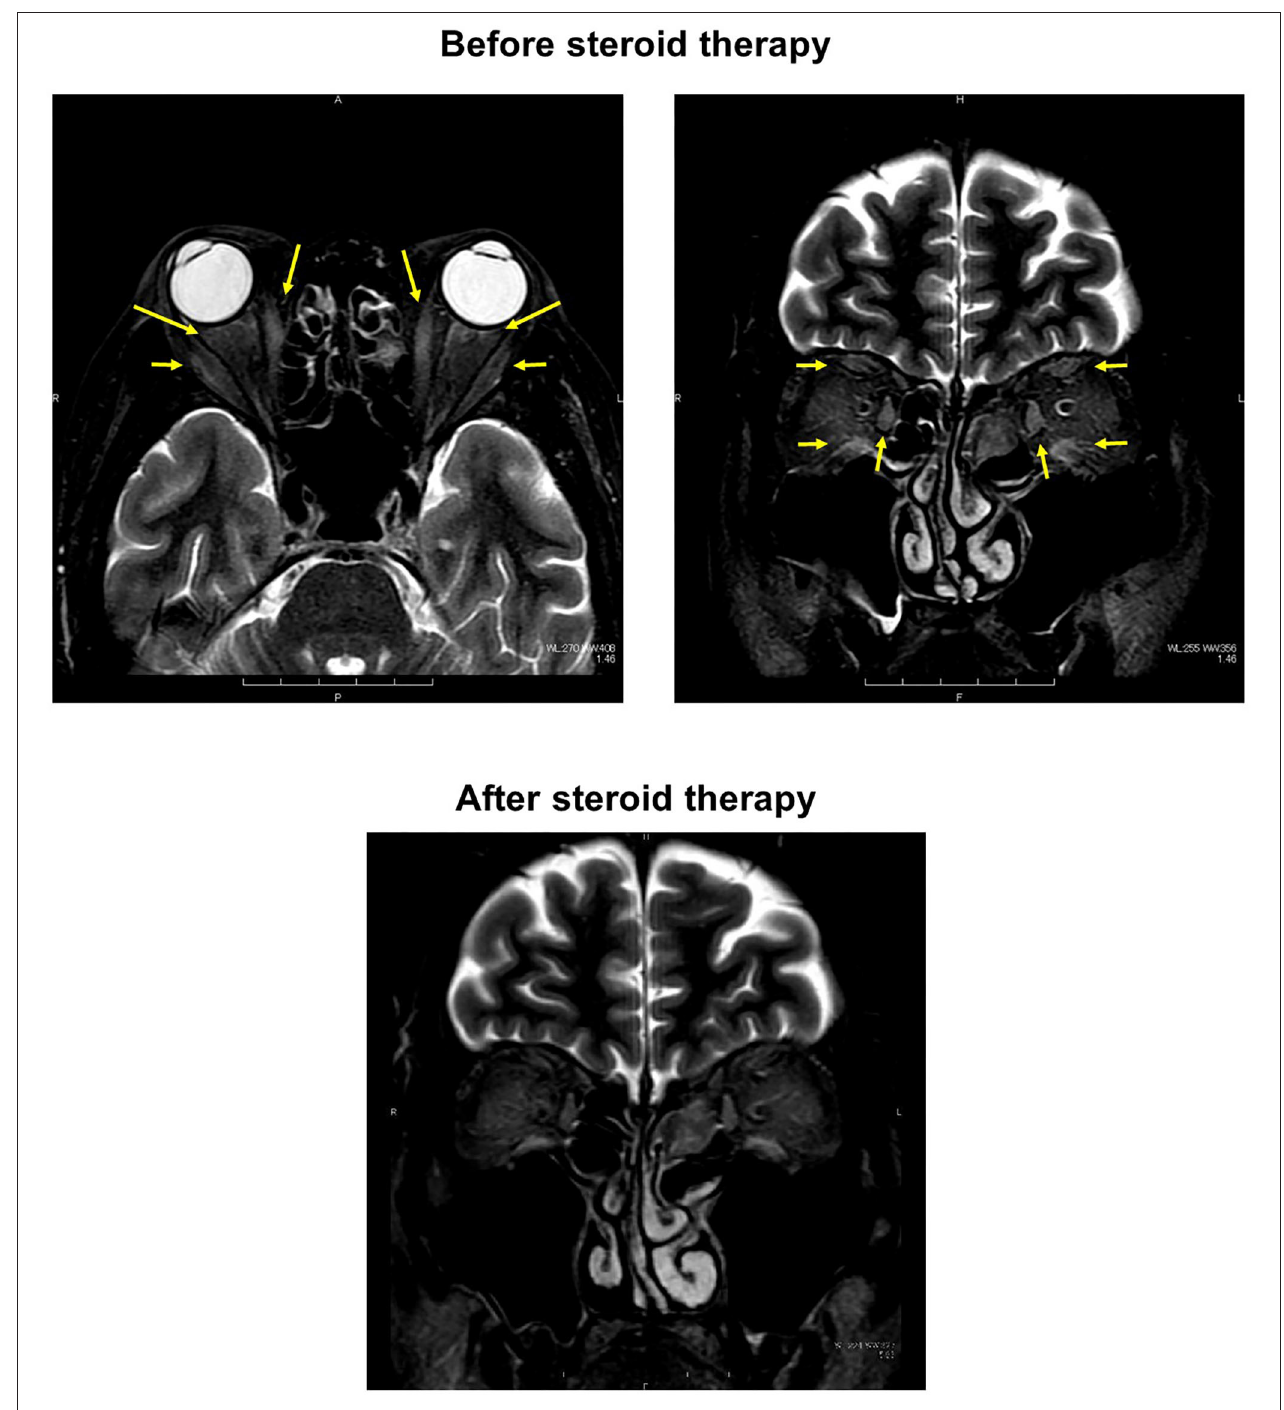
FIGURE 2 | (Upper) In orbital magnetic resonance imaging before starting treatment, some high signal was detected in both extraocular muscles, indicating that inflammation extended into the extraocular muscles in this subject (both panels; yellow arrows). (Lower) After the steroid pulse therapy, signal intensity in extraocular muscle tended to be weakened, and orbital fat mass was moderately